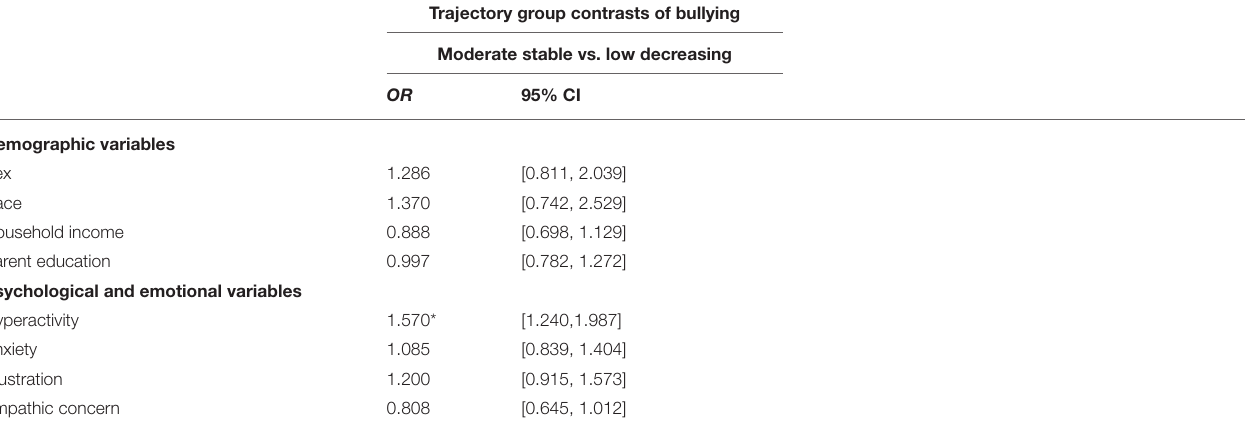
Trajectory group contrasts of